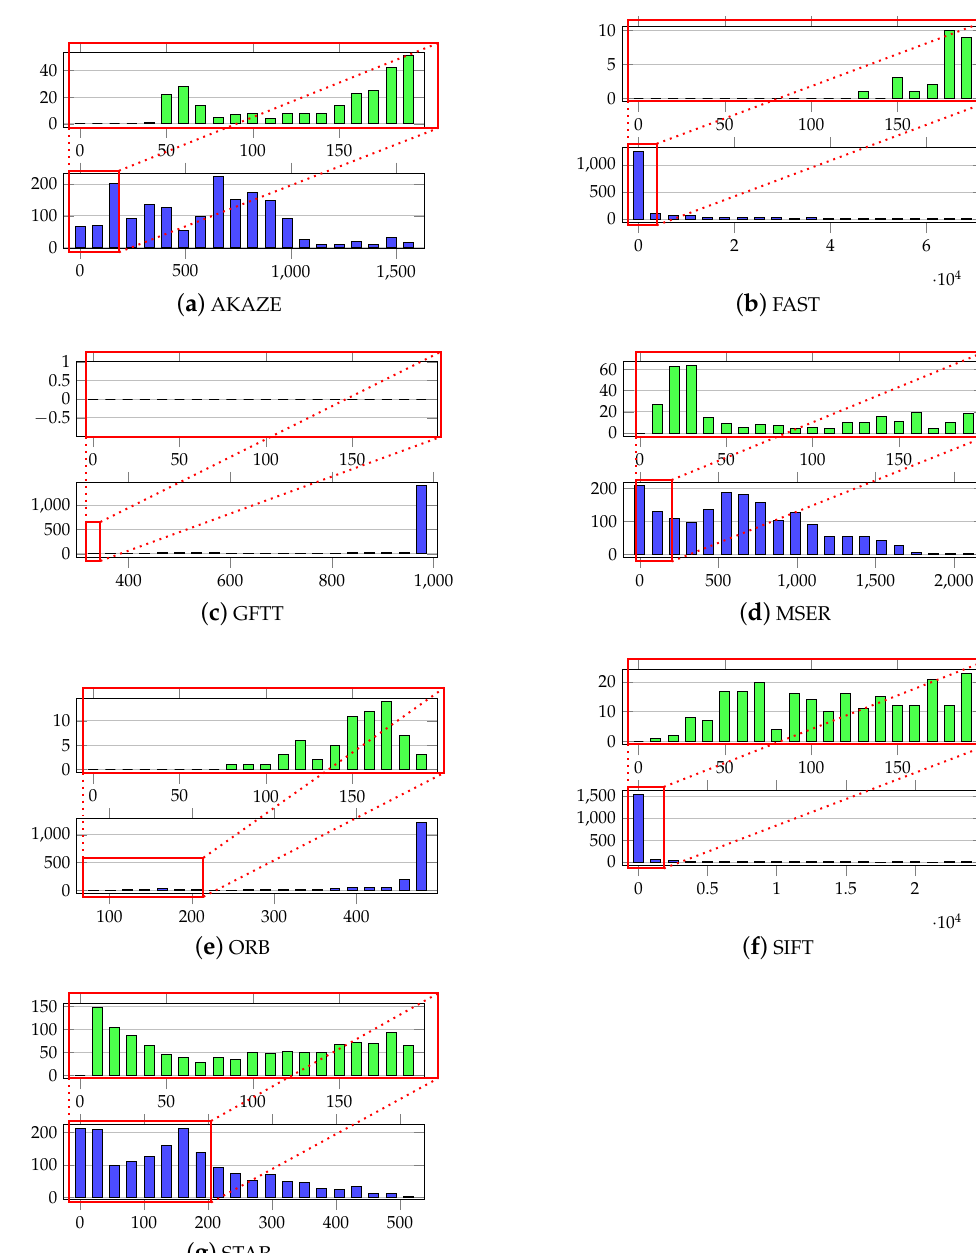
Figure 5. Examples of keypoint distribution over classes in the WrightBroS database. The histogram on the bottom shows distribution over the full keypoint number range, while the one on the top concentrates only on the range